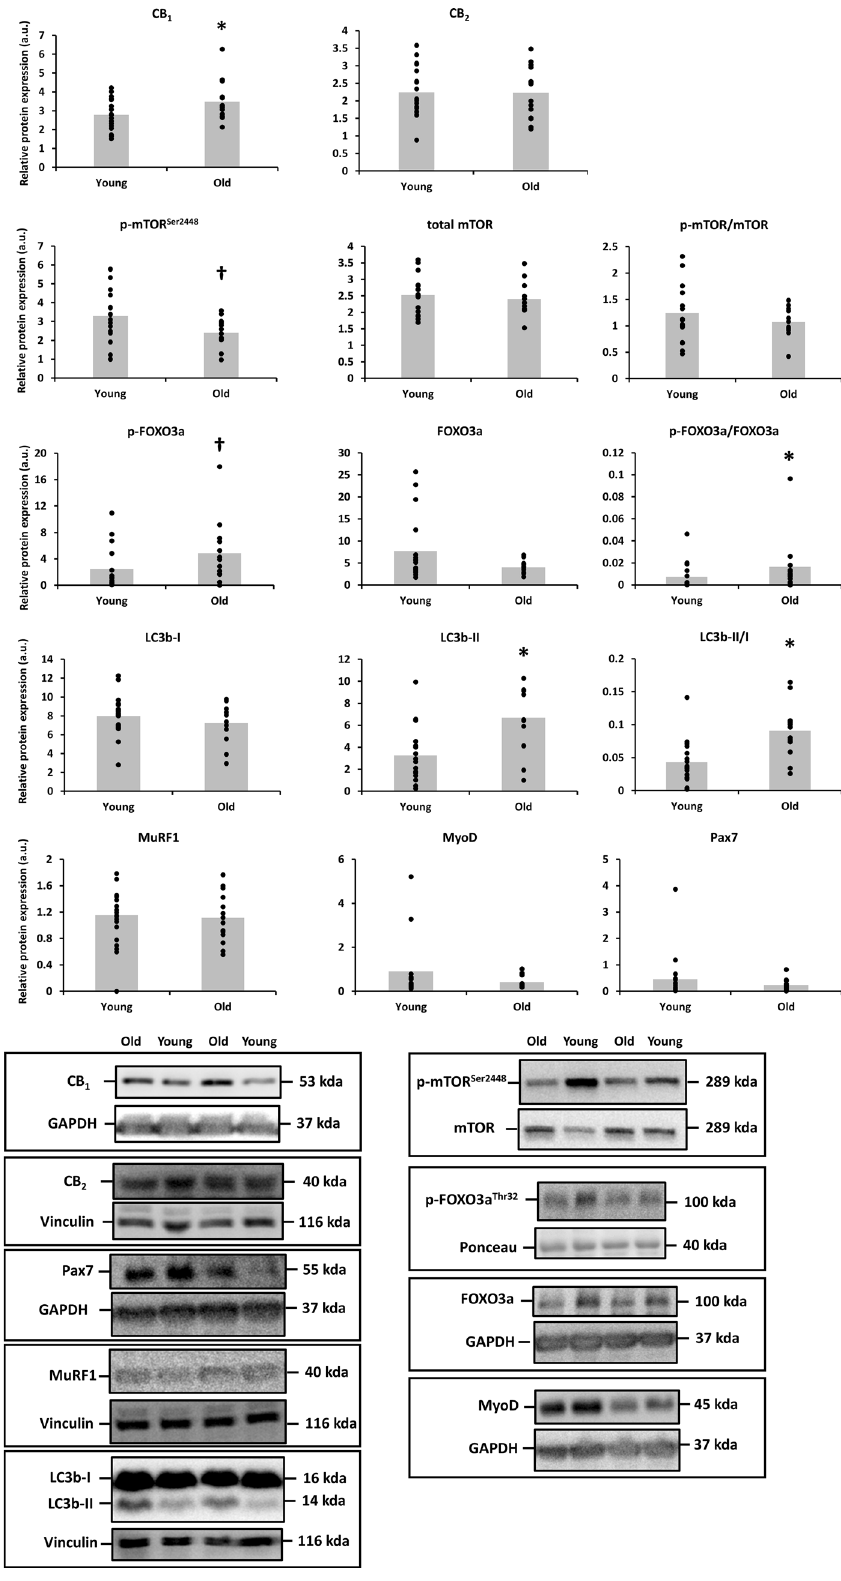
Figure 1. Differences in the protein expression of cannabinoid receptor 1 (CB 1 ), CB 2 and phospho and total mammalian target of rapamycin (mTOR) at Ser2448, phospho and total forkhead box O (FOXO)3a at Thr32, microtubule-associated protein 1A/1B-light chain 3 (LC3b), muscle RING finger-1 (MuRF1), MyoD and Pax7 between skeletal muscle of young (n = 18) and old adults (n = 14). Protein targets were normalized to glyceraldehyde 3-phosphate dehydrogenase (GAPDH), vinculin or the total protein form. Data are shown as mean (bar graph in grey) with individual data points (black dots superimposed on the bar graphs). *p < 0.05 and † p = 0.05– 0.10 for Independent-Samples t Test or Mann–Whitney U Test. Raw western blot data of all replicates are displayed in Supplementary Figure 2. Ponceau red staining of the presented western blots are included in Supplementary Figure